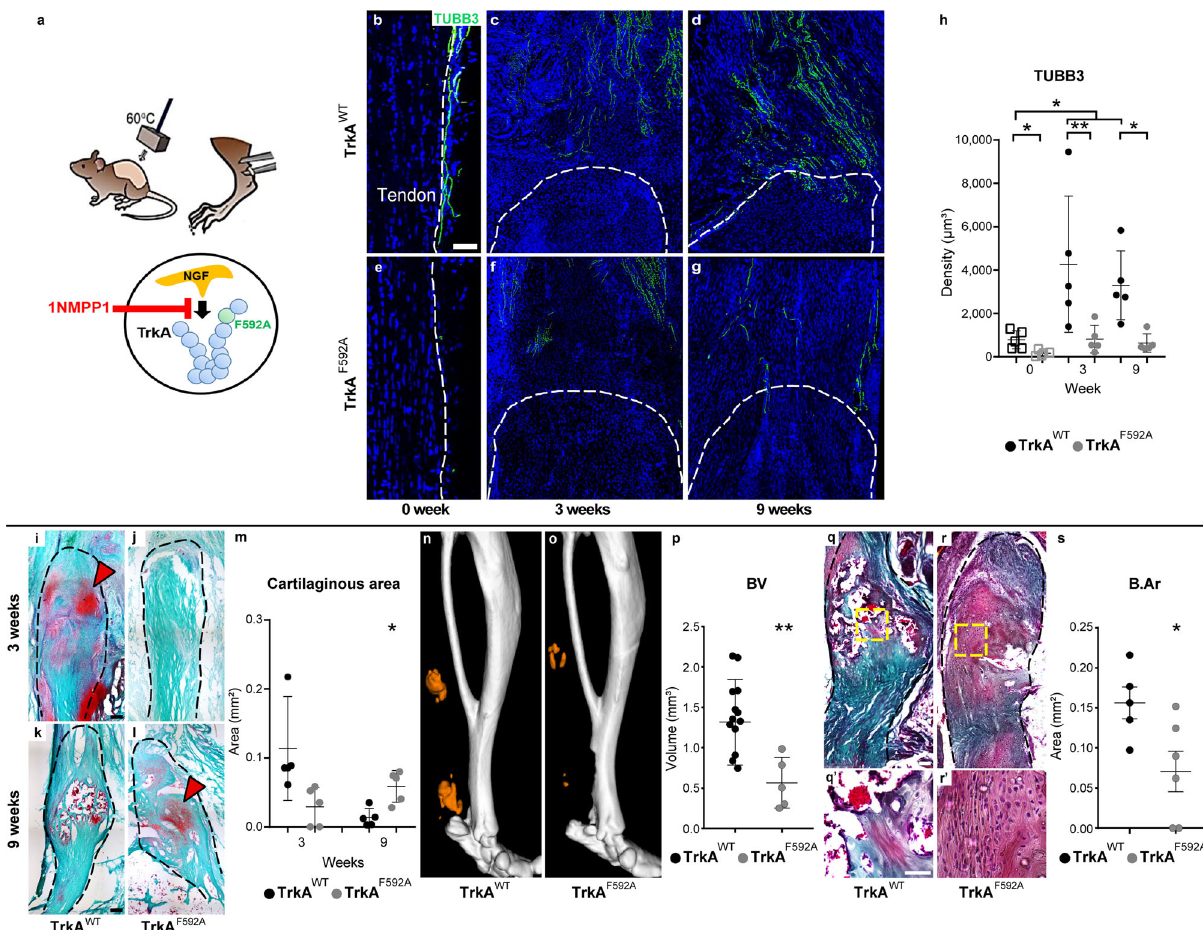
Fig. 6 TrkA inhibition within TrkA F592A mice inhibits heterotopic ossi fi cation (HO). a Schematic representation of the experiment. TrkA F592A mice